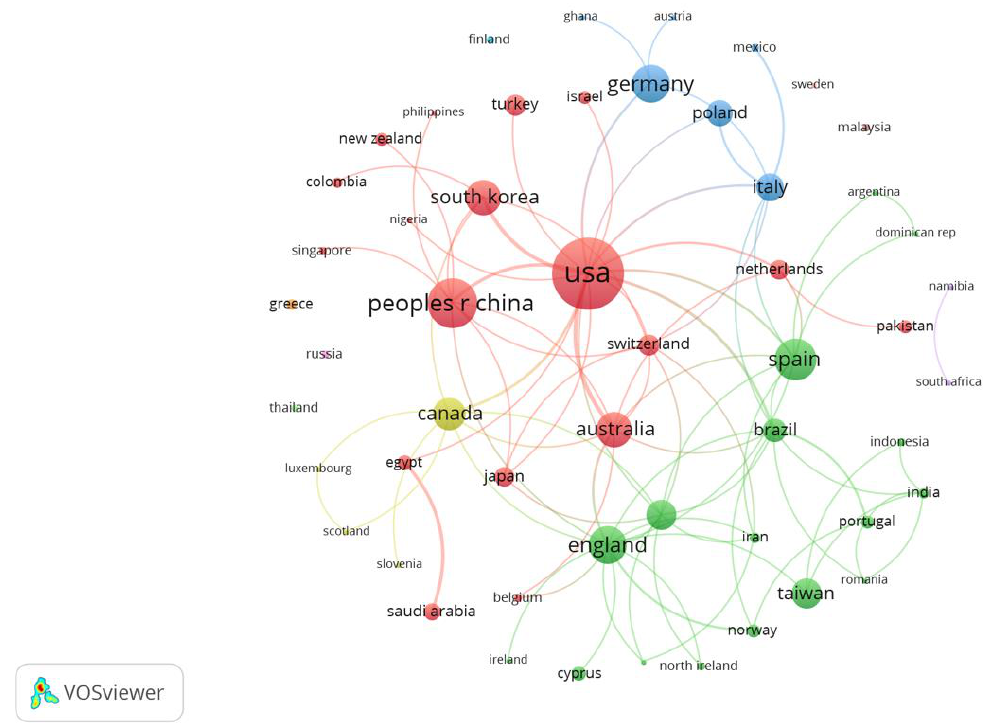
Figure 4. Co-authored countries/regions. Analysis: fractionalization, attraction: 7, repulsion: 0, clustering: resolution (0.5), minimum cluster size: 3, node side: documents, colour: cluster.